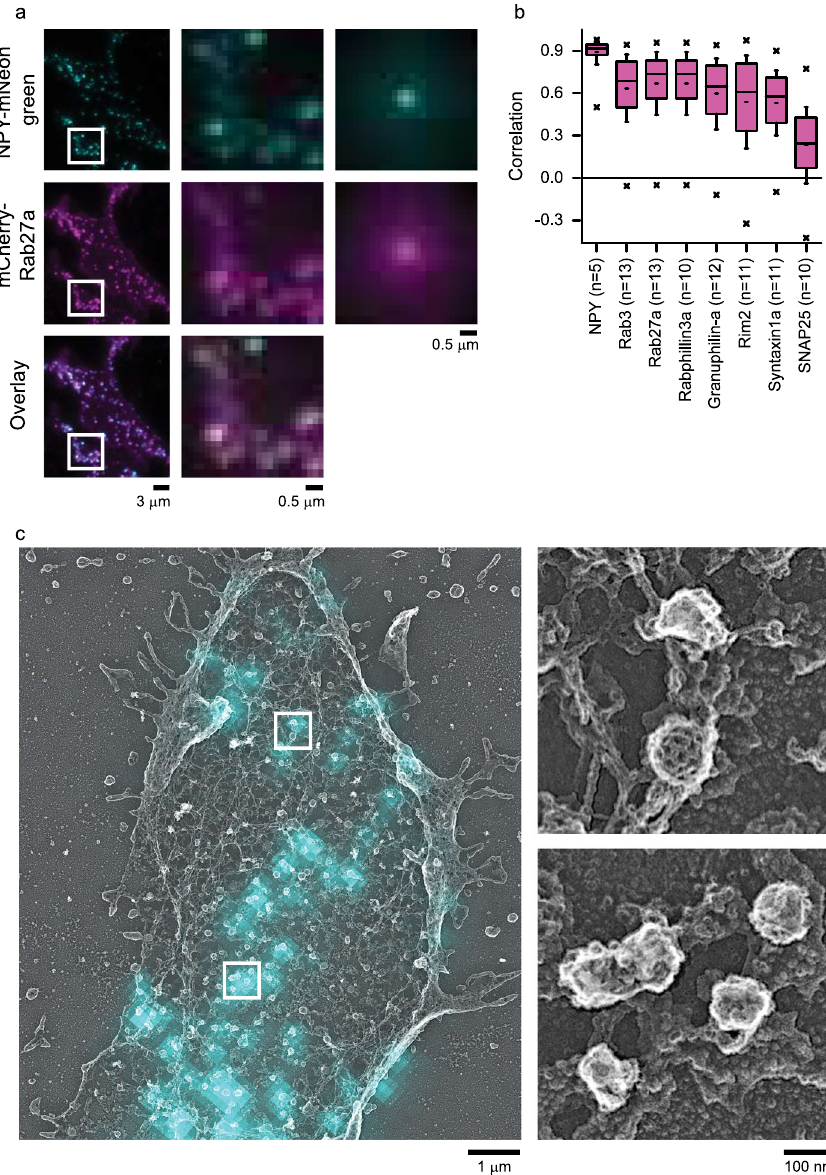
Fig. 1 Imaging key DCV proteins on single vesicles with light and electron microscopy. a TIRF microscopy images of PC12 cells co-transfected with NPY- mNG ( fi rst row), Rab27a-mCherry (second row), and their overlay (third row). Left column shows representative cell image with scale bar, 3 μ m. Middle column shows the enlarged images from white boxes on left column fi gures. Scale bar is 0.5 μ m. Small regions from 5 cells normalized to the brightest pixel and averaged together (right column, scale bar is 0.5 μ m). b Correlation analysis of 8 proteins with NPY-mNG – labeled DCVs in unroofed PC12 cells. Left most bar labeled NPY is a control of cells co-transfected with NPY-mNG and NPY-mCherry. “ n ” next to the proteins denotes the number of cells analyzed from one correlative experiment. Pink boxes are the 25th – 75th percentile range of data, and the whiskers are the SD. The solid bar is the median, and the small dash is the mean. The × marks above and below each data set are the 1st and 99th percentiles. c TIRF NPY-mNG image (cyan) overlaid with PREM image (gray) of the unroofed PC12 cell membrane. This image was selected from one of the four independent experiments performed for Rab27a immunolabeled PC12 cells. Single DCV and DCV cluster (right panel) from white boxes in the left panel. Honeycomb vesicle in the top panel is a clathrin- coated pit. Scale bars are 1 μ m and 100 nm for left and right panels, fl uorescence pro fi les by outlining the NPY-mNG identi fi ed vesicles in EM and analyzing the average normalized fl uores- cence pixel values as a function of distance from either the center Figure 2a – e shows dSTORM images aligned with PREM or edge of the vesicle. The detailed analysis work fl ow is shown in images for proteins labeled with Alexa Fluor-647 conjugated Supplementary Fig. 2. For radial pro fi les (Fig. 2h), we binned GFP nanotrap. CLEM images for all fi ve proteins (Rab3a, pixels in 12 nm increments from the center of a vesicle up to 18 Rab27a, Rabphilin3a, Rim2, and Granuphilin-a) show fl uores- bins (Fig. 2f, g). And, for edge pro fi les (Supplementary Fig. 5), we cence on or close to dense-core vesicles. To measure the binned as previously described for clathrin-coated pits 16 — 5 bins inward and 10 bins away from the vesicle edge. Both radial and association of these proteins with vesicles, we generated